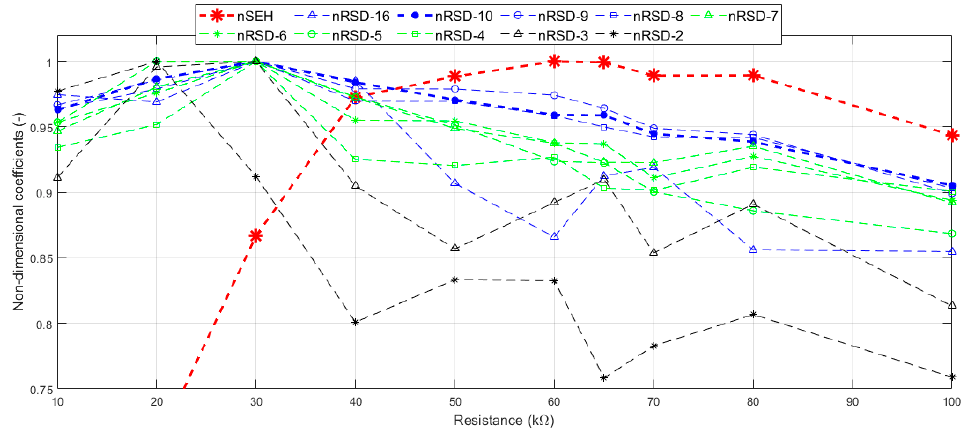
Figure 11. Comparison of coefficients for energy harvesting and passive vibration damping.